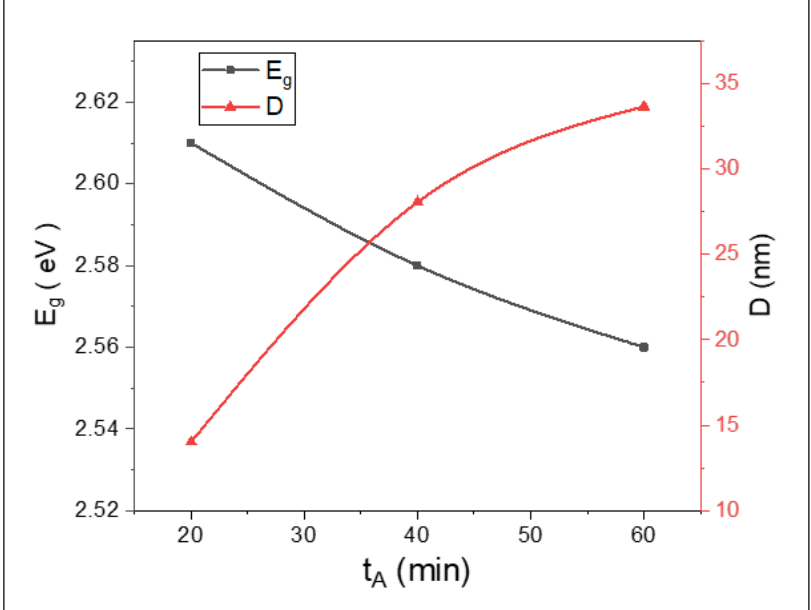
Figure 12. Variation of energy gap as a function of annealing time and crystallite size.